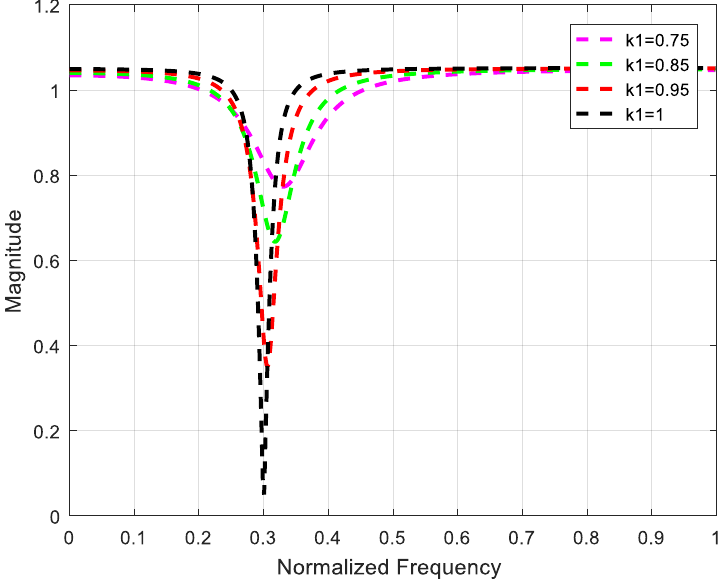
Figure 8. Characteristics of the notch related to filter parameters: notch depth vs. 𝑘 1